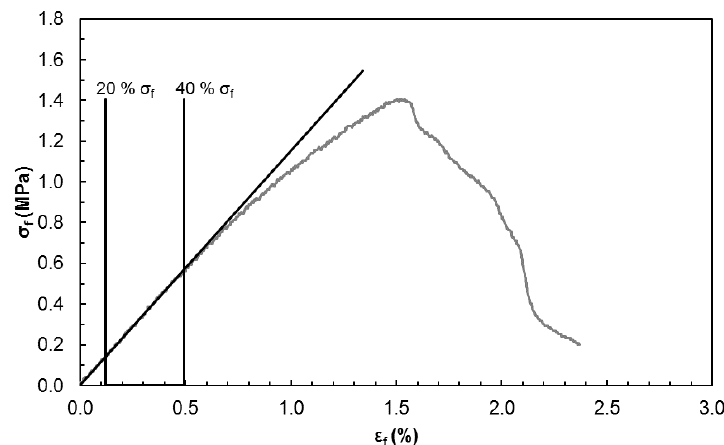
Figure 2. Stress-strain curve and corresponding slope determined between 20% and 40% of the maximum flexural strength.